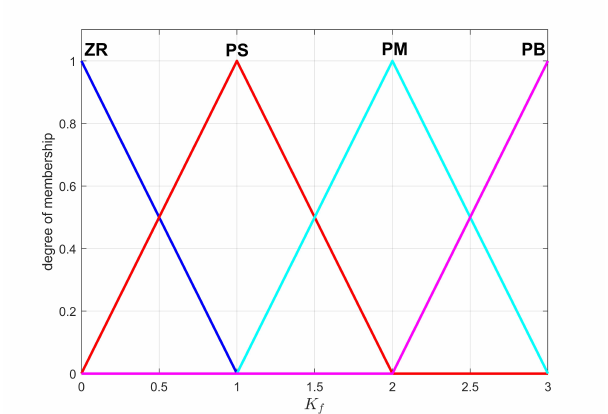
Figure 4. Fuzzy input membership functions.